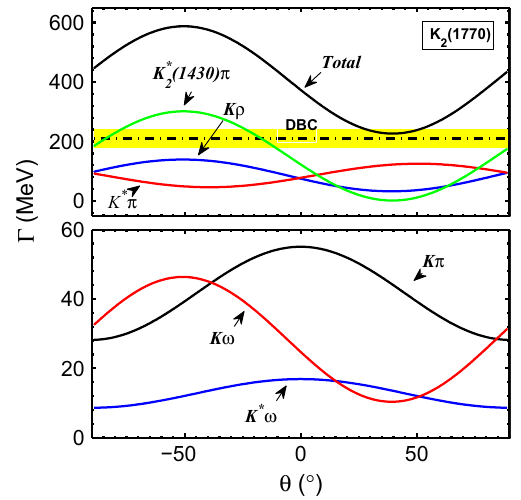
Fig. 6 θ 1 D dependence of the width of K 2 ( 1770 ) , where the dot- dashed line is the experimental value of DBC [69]